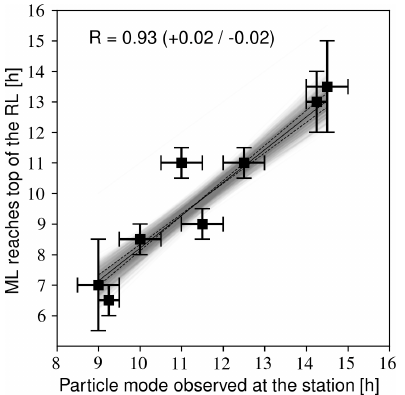
Figure 7. The correlation between the times when a new particle mode coupled with downward particle flux was observed at the field site and the times when the ML reached the top of the RL.